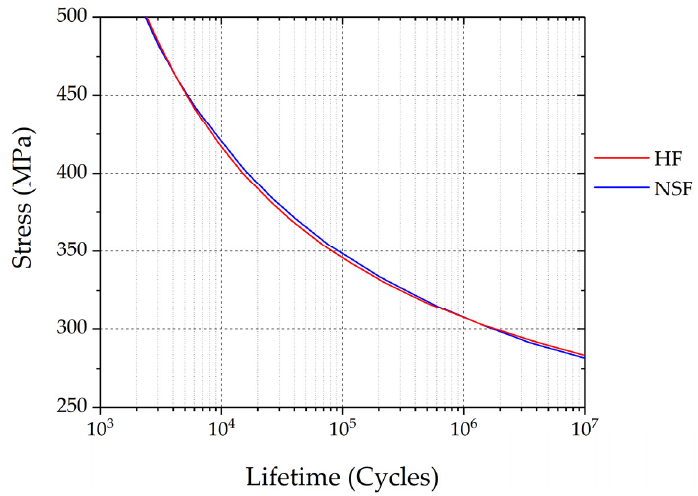
Figure 10. Comparison of the fatigue Pf = 50% curves of the hot ‐ forged and NSF components.